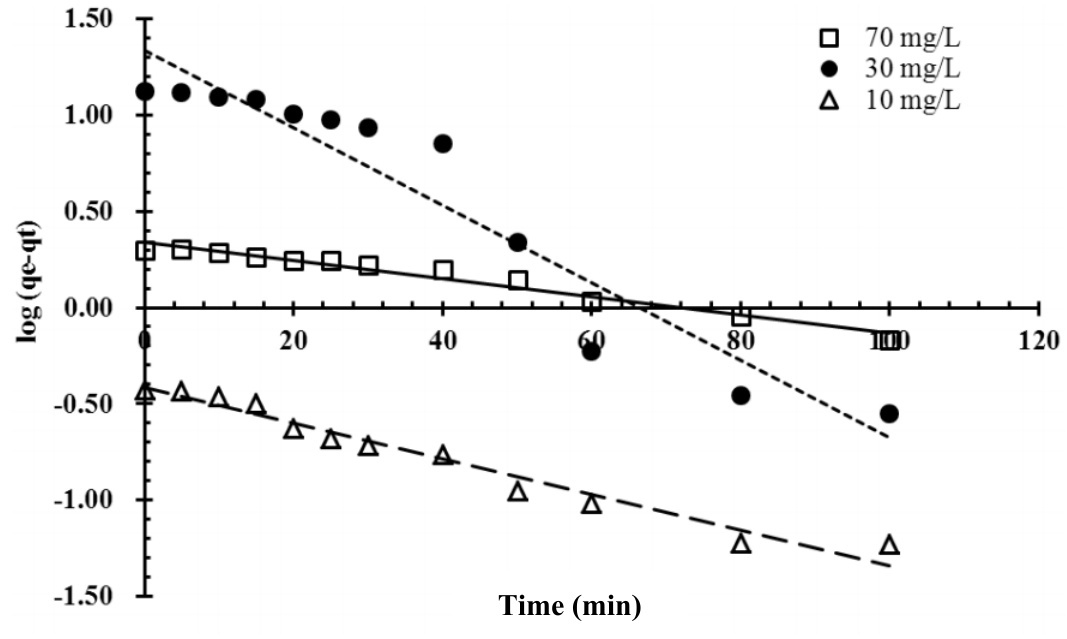
composite beads.